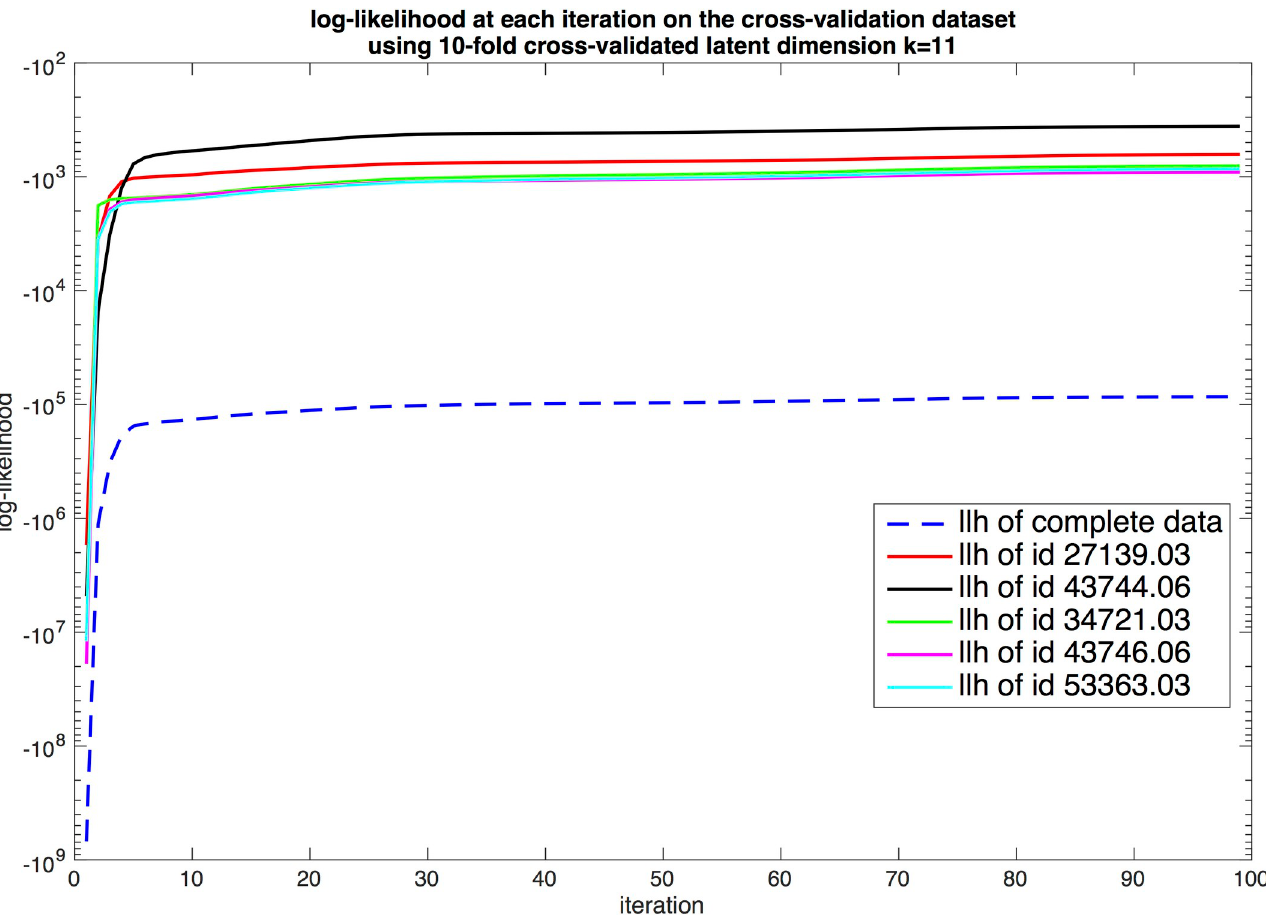
Fig 8. Convergence history of the log-likelihood of the complete cross-validation dataset and a sample of the convergence history for 5